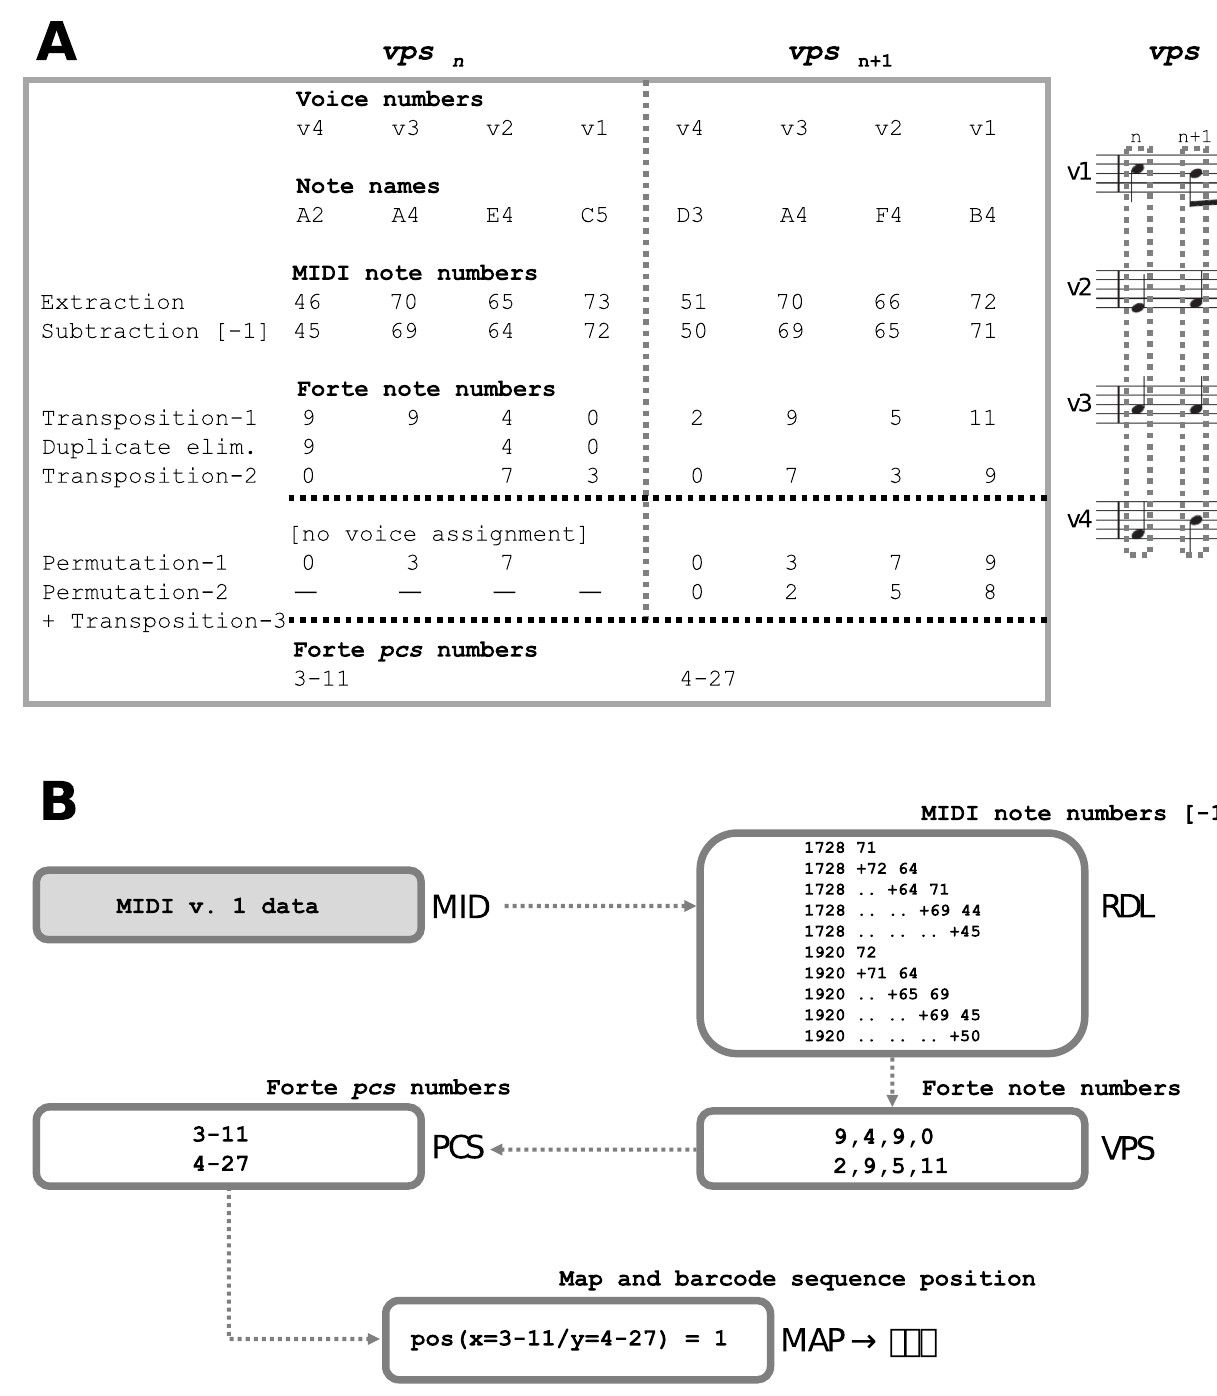
Fig 1. Data flow from multi-track MIDI files to RAMEAU intermediate processing files for subsequent generation of fingerprints, barcodes and the alignment as used for tree generation. A. Data flow from a MIDI input file to a pcs listing (all in UTF-8 encoding format). [MID: MIDI; the input files must follow the multi-track MIDI standard (v. 1); RDL: Reduced Data Listing files provide all basic information required for analyses based on VPS files, supplying all information concerning tone = pitch (as MIDI note numbers), duration of tone for every track = voice; VPS: Vertical Pitch Set files include successive vertical pitch sets; PCS: Pitch Class Set files include the successive vertical pitch sets (as ‘Forte name/numbers’]. B. Data flow schema from a multi-track MIDI input file to a MAP fingerprint file and to SEQ barcode sequence data (to be copied or exported from the cmd window under local MS Windows).